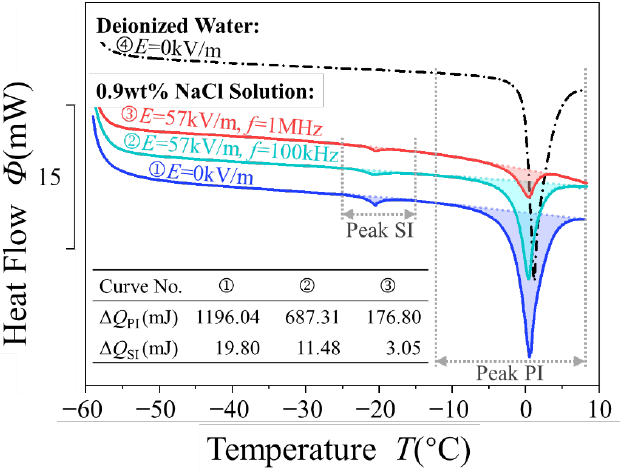
Figure 3. DSC rewarming curves of 0.9 wt % NaCl solution after non-field cooling and field cooling.